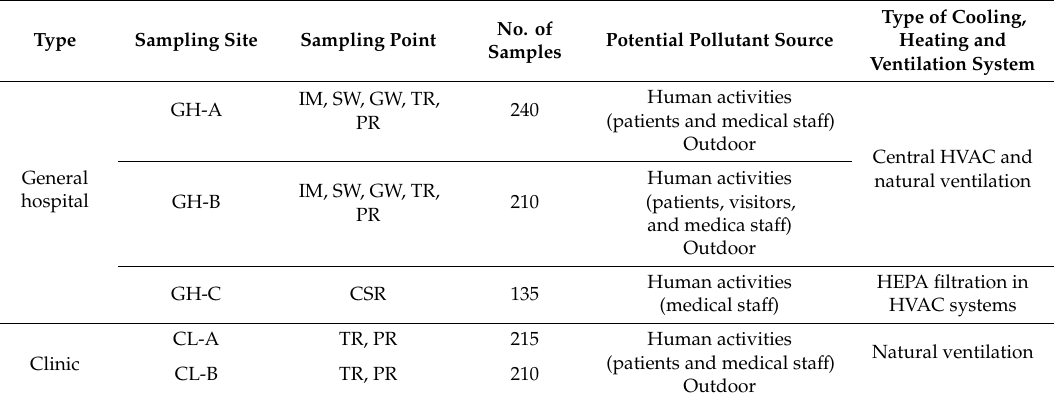
Table 1. Characteristics of the sampling sites selected for this